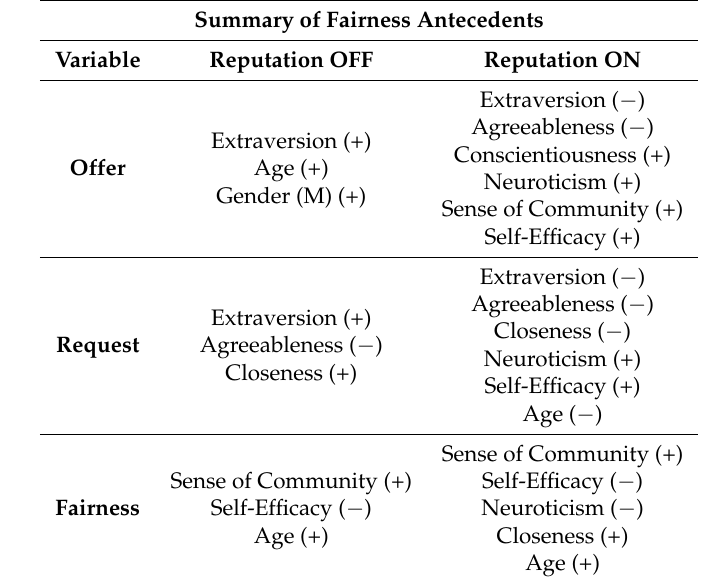
Table 8. Psychological antecedents of fairness. In the table is reported a summary of the socio-psychological characteristics that influence fair bargaining behaviors with and without a reputational